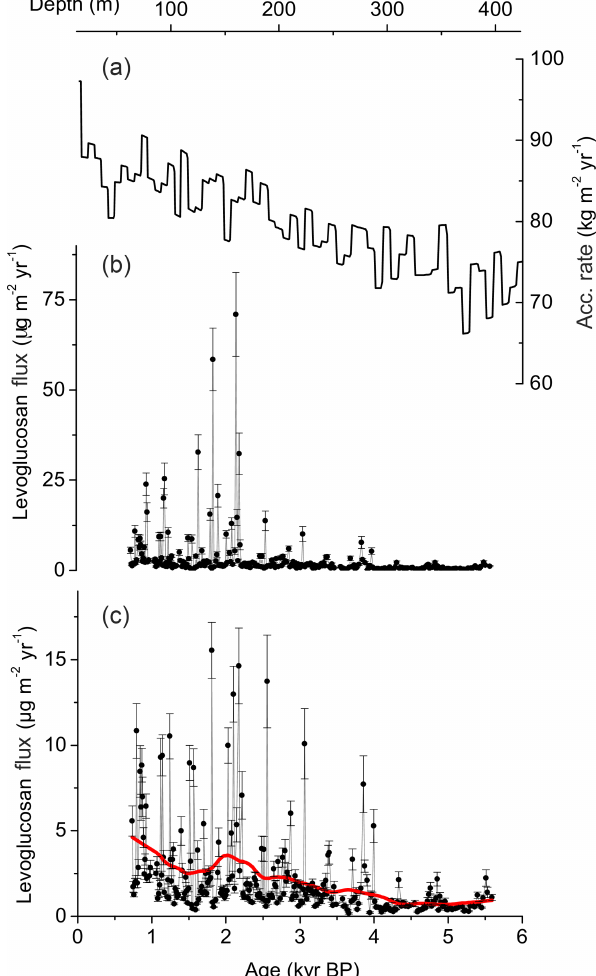
Figure 2. (a) Accumulation rate (from Veres et al., 2013). Com- plete (b) and without anomaly (c) levoglucosan record (LOWESS smoothing with SPAN parameter 0.2 (red)) from